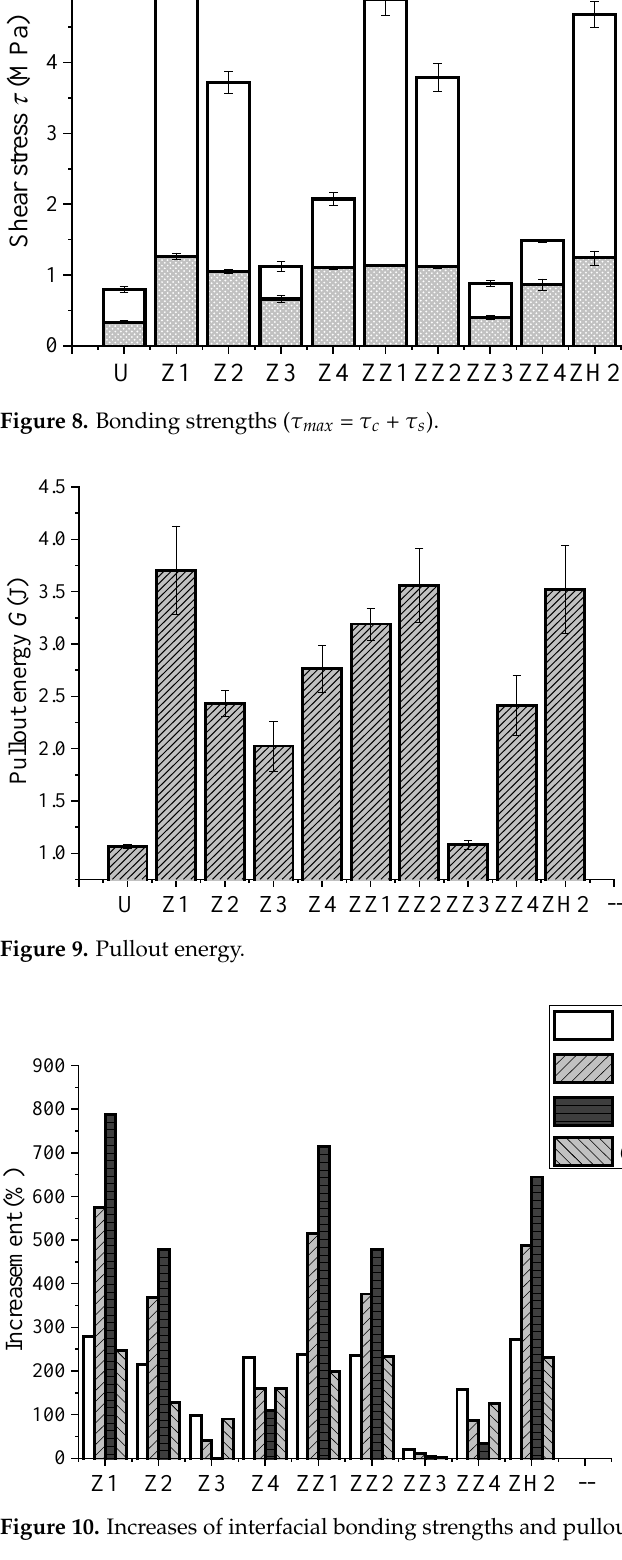
( f ) Figure 11. SEM micrographs and EDS spectra of steel fibres before pullout tests: ( a ) A micrograph of group U; ( b ) A mi- crograph of group Z1; ( c ) A micrograph of group ZZ1; ( d ) EDS spectra of group U; ( e ) EDS spectra of group Z1; ( f ) EDS spectra of group ZZ1. The coating mechanism can be explained in chemical reactions. The chemical structure of silane molecules is represented by R-Si(OX) 3 , where R represents car-